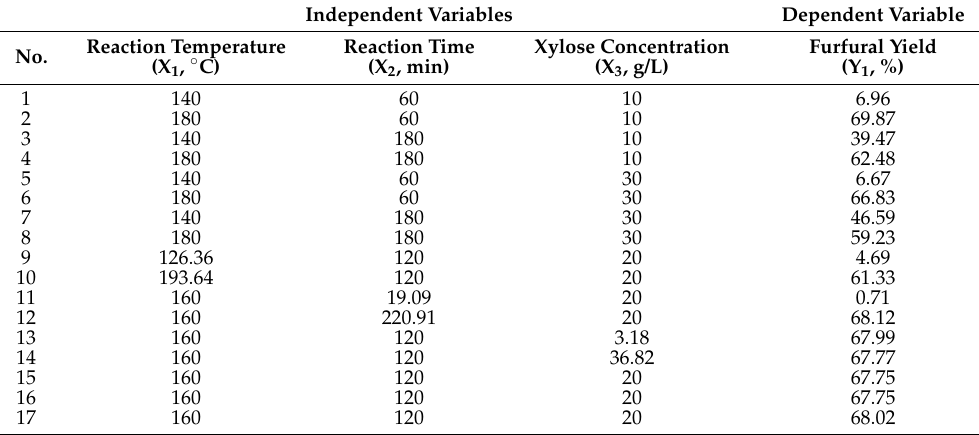
Table 2. 2 3 factorial experimental design varying on 3 factors and results of furfural